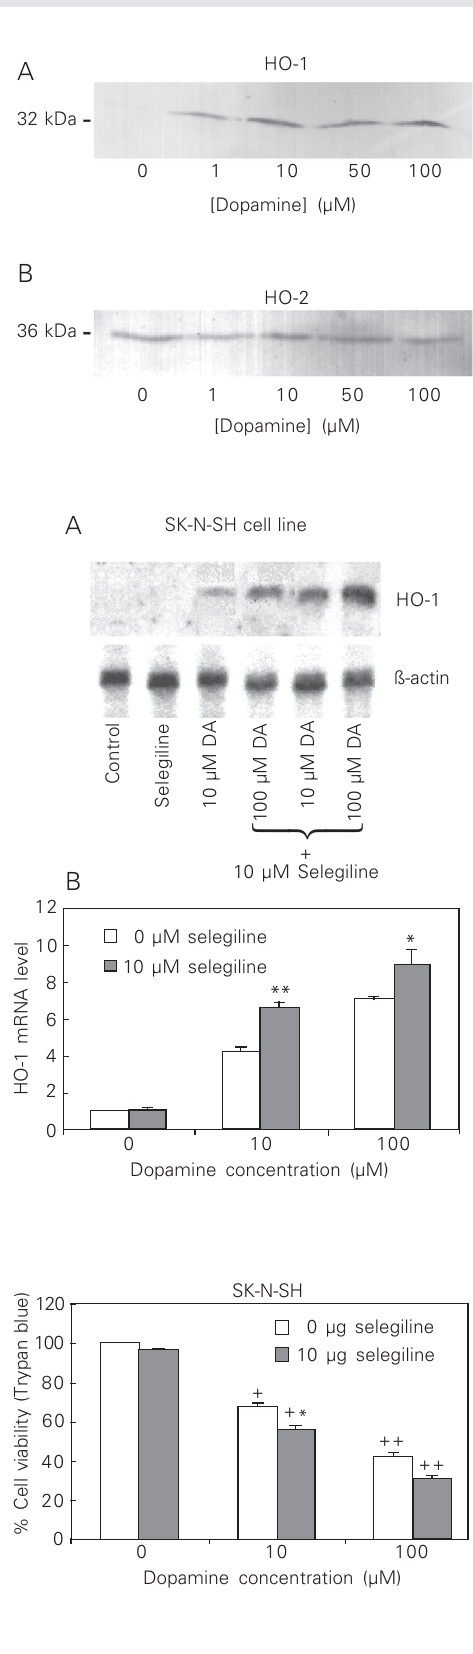
Figure 2. Effect of dopamine treatment on HO protein ex- pression in SK-N-SH cell line. A , Immunoblot of the homoge- nate incubated with anti-HO-1 (1:2000). B , Immunoblot of the homogenate incubated with anti-HO-2 (1:2000). The molec- ular weight is shown on the left. Twenty micrograms of protein was loaded per